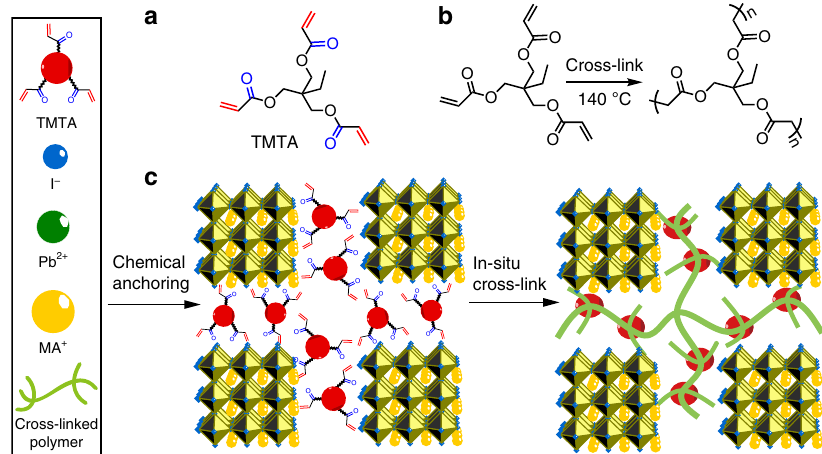
Fig. 1 Schematic illustrations of in-situ cross-linked organic/perovskite fi lms. a Chemical structure of TMTA with marked carbonyl (blue) and alkenyl (red) groups. b Cross-linking polymerization of TMTA under thermal conditions. c Working mechanism of TMTA in PSCs: TMTA chemically anchors to the grain boundaries of MAPbI 3 and then in-situ cross-links to a continuous network polymer